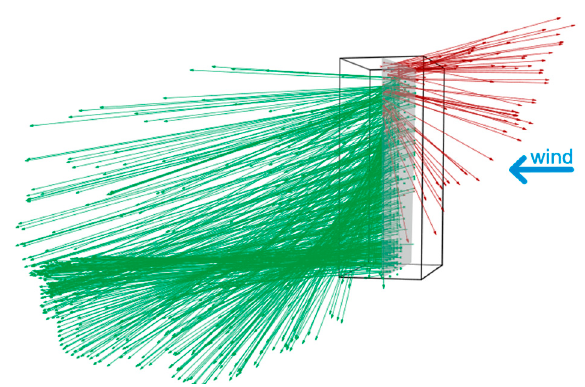
Figure 8. Velocity vectors coming through the opening (in red: recirculation flows).